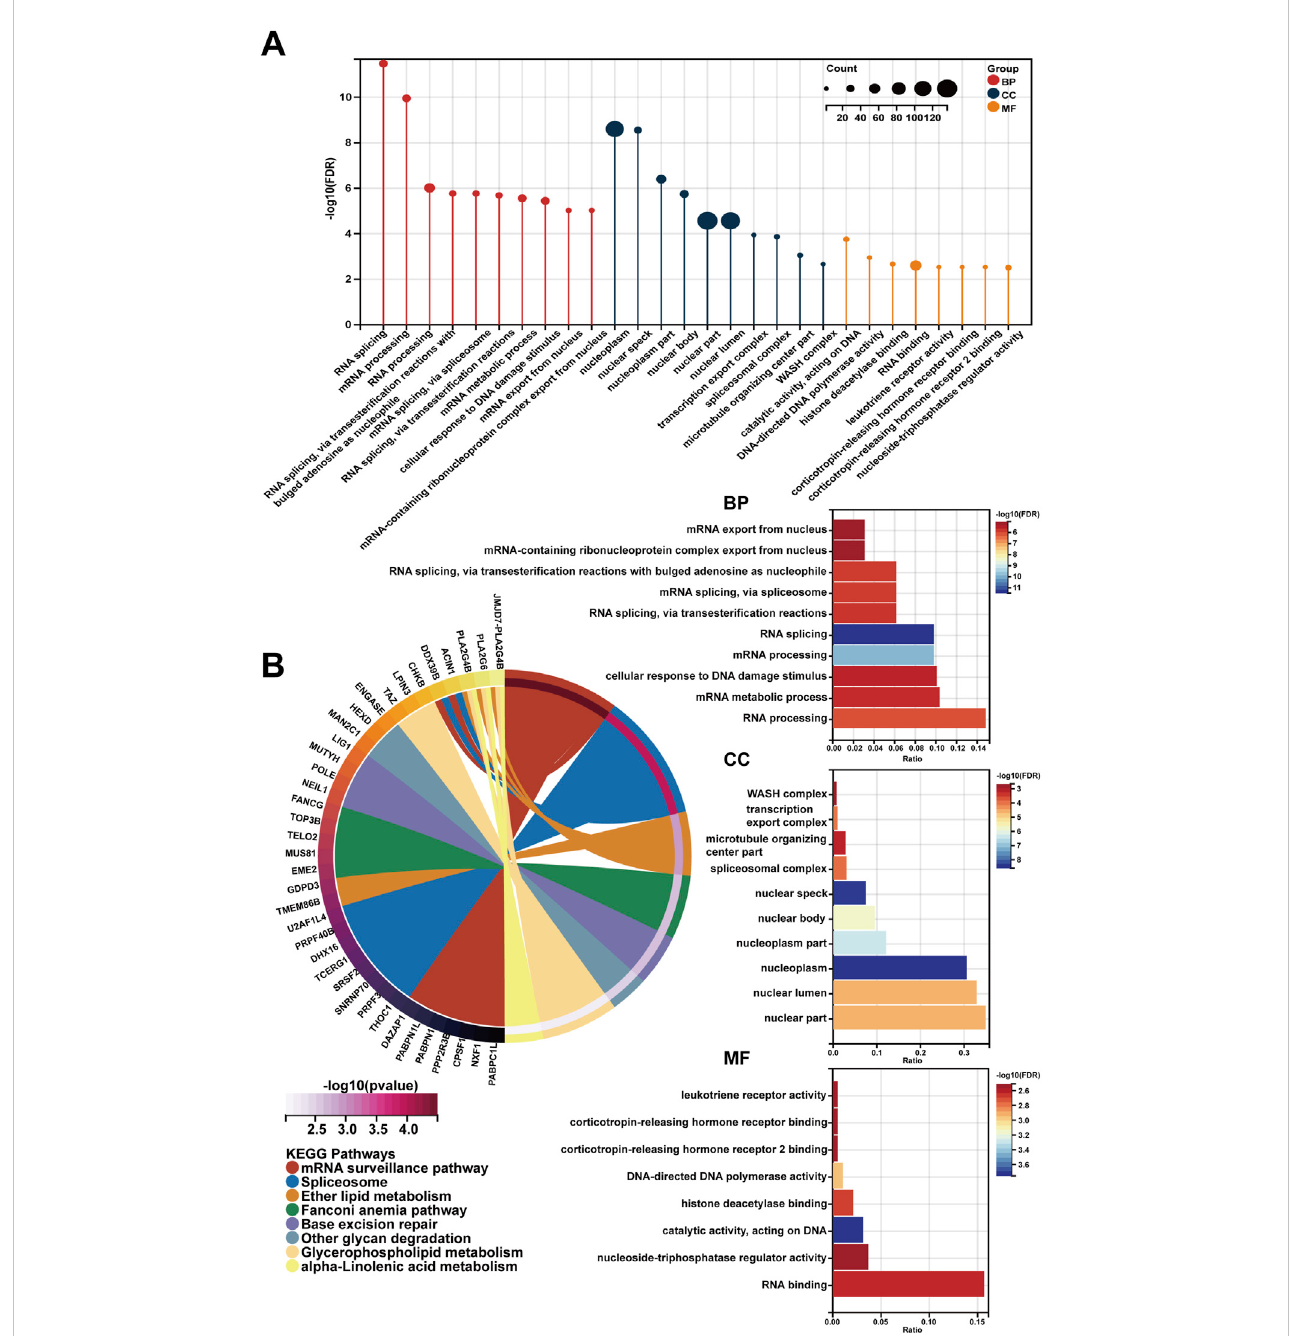
FIGURE 8 ThefunctionalenrichmentanalysisofagenesetincludingRP11-468E2.5anditssimilargenes. (A) Thediagrams showthetop10termsinthreeparts(BP, CC, and MF) of the GO analysis. (B) The top eight pathways in the KEGG